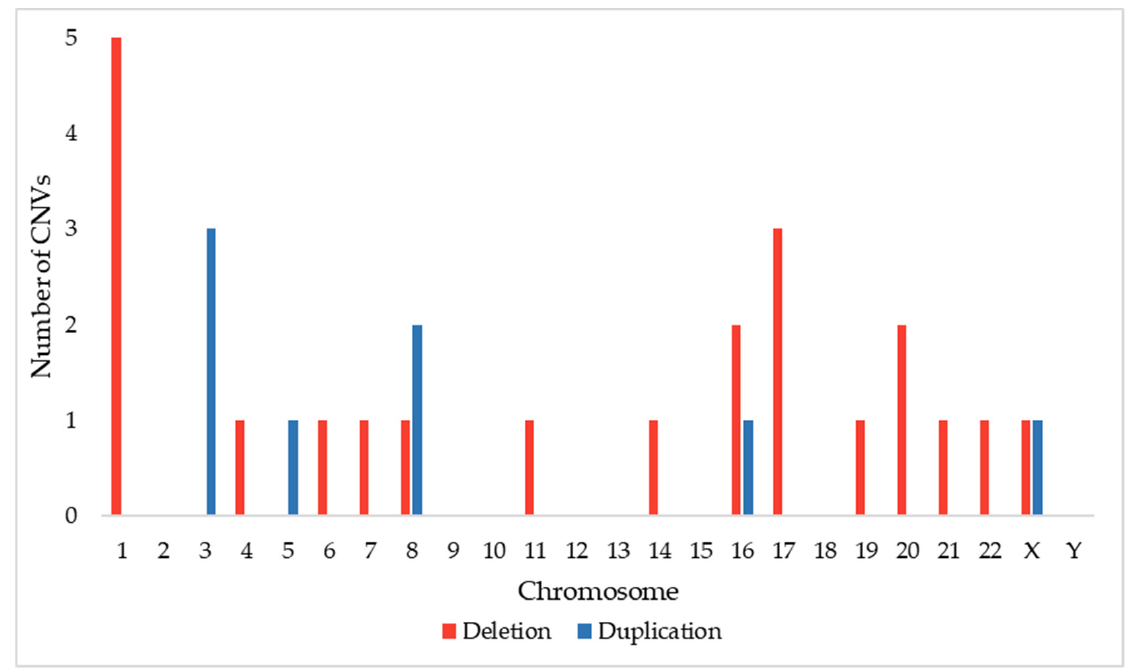
Figure 1. Frequency of chromosomes harboring rare de novo <500 kb CNVs detected in 29 macroce- phalic patients described in the DECIPHER database.